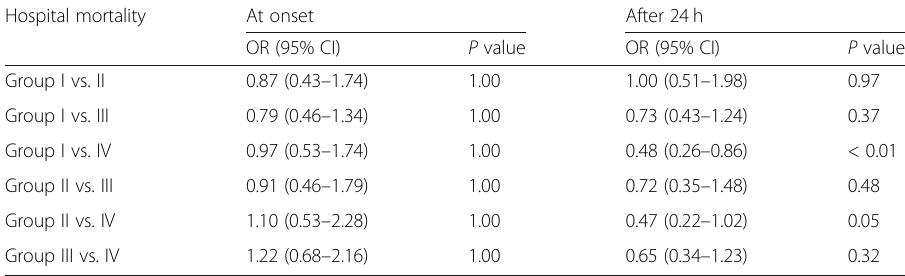
Table 3 Intergroup comparisons for hospital mortality at onset of hypoxemia and after 24 Hospital mortality At onset After 24 h